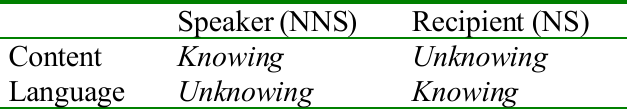
Complementary Distributed Knowledge in Native and Non-Native